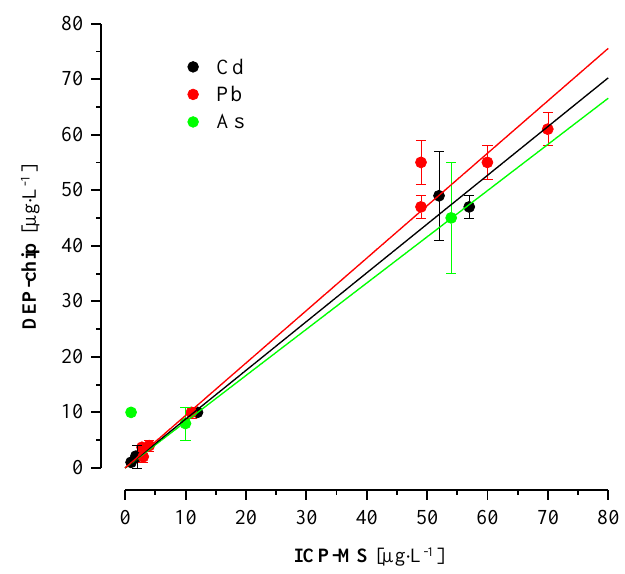
Figure 5. A correlation curve between the conventional (ICP-MS) and “DEP-On-Go” device for sensitive detection of cadmium, lead, and arsenic heavy metals in drinking groundwater samples.